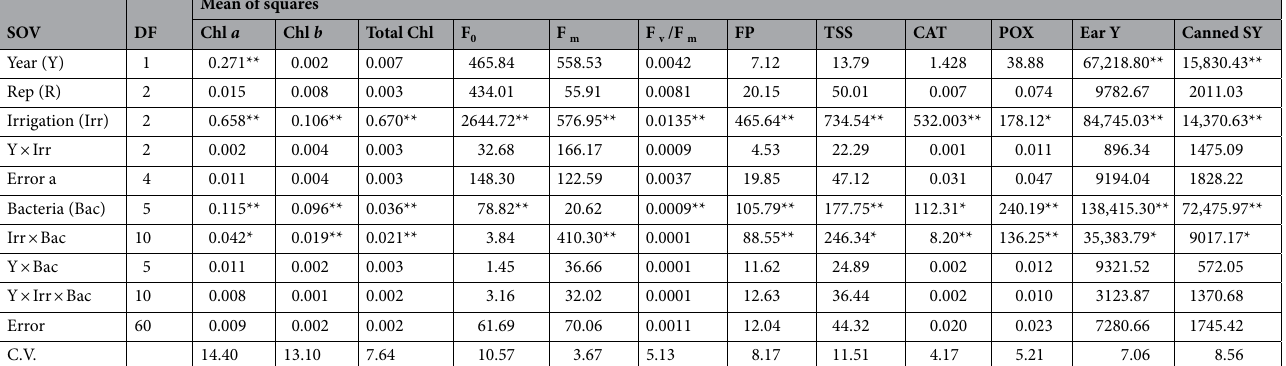
Table 4. Variance analysis of the effect of irrigation levels and bacterial inoculation on physiological traits and yields of sweet corn. Chl a: chlorophyll a, Chl b: chlorophyll b, Chl a + b: total chlorophylls, F0, Fm and Fv/Fm: chlorophyll fluorescence parameters, FP: free proline, TSS: total soluble sugars, CAT: Catalase, POX: Peroxidase, Ear Y: ear yield, Canned SY: Canned seed yield. *Indicates p ≤ 0.05; ** indicates p ≤ 0.01; C.V. indicates coefficient variance; Rep indicates replication (n = 3); DF indicates degree of freedom; S.O.V indicates source of variance.